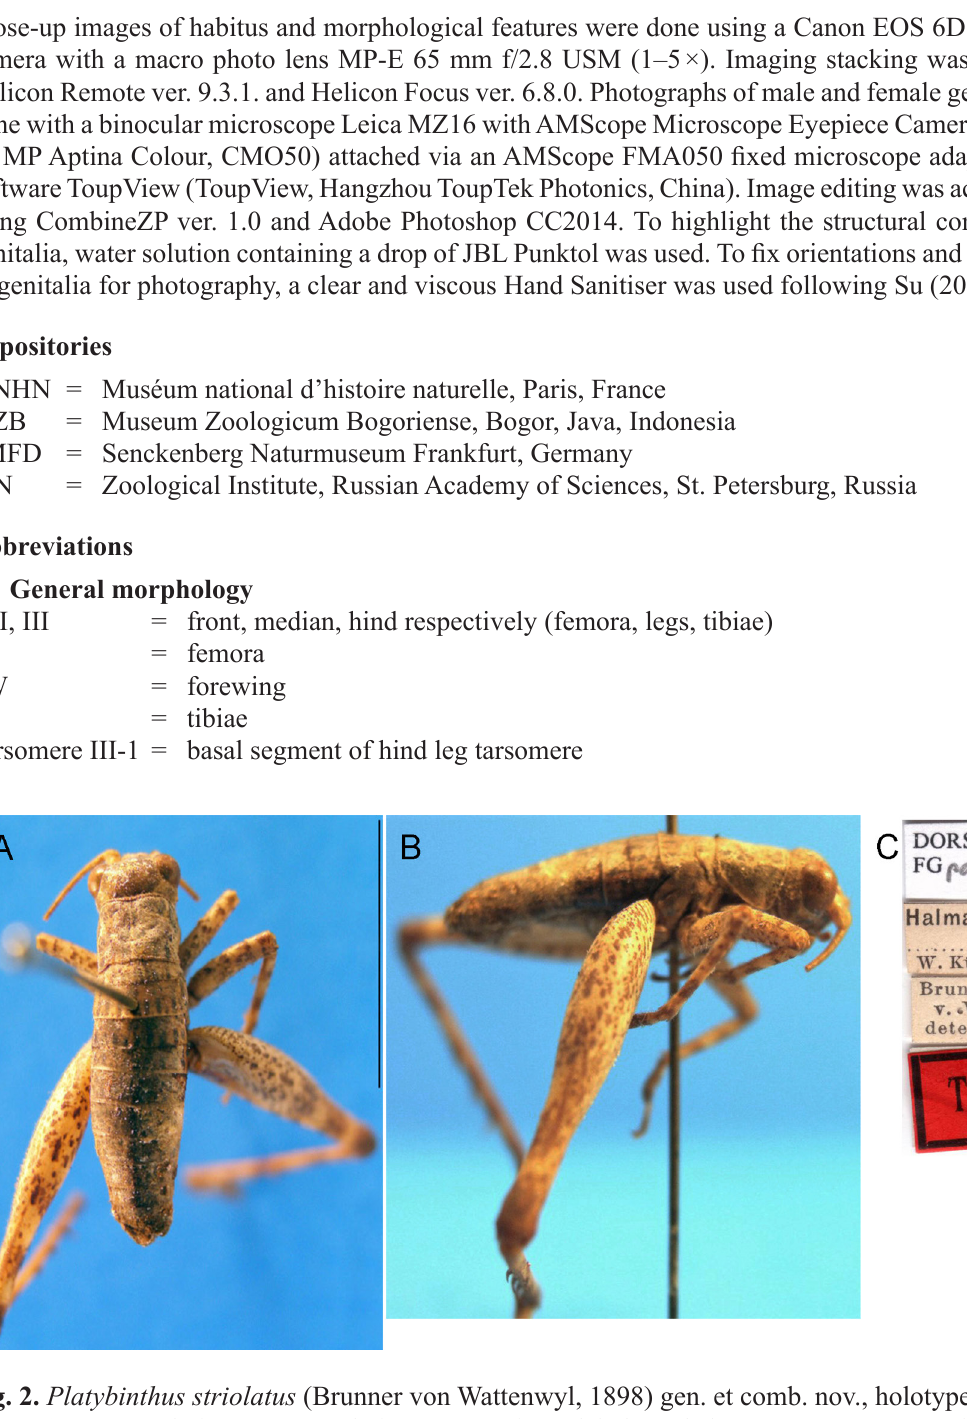
Fig. 2. Platybinthus striolatus (Brunner von Wattenwyl, 1898) gen. et comb. nov., holotype, ♂ juvenile (SMFD). A . Dorsal view. B . Lateral view. C . Specimen label. Scale bar = 10 mm. Images obtained from Orthoptera Species File online (Cigliano et al.